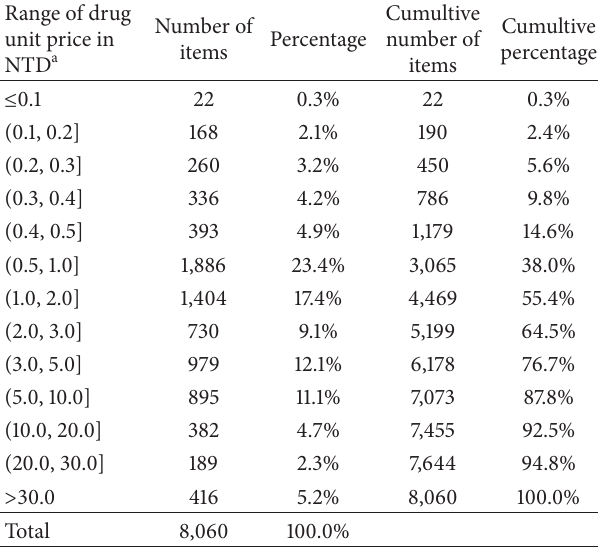
Table 1: Oral pills (tablets and capsules) reimbursable within Taiwan’s National Health Insurance in